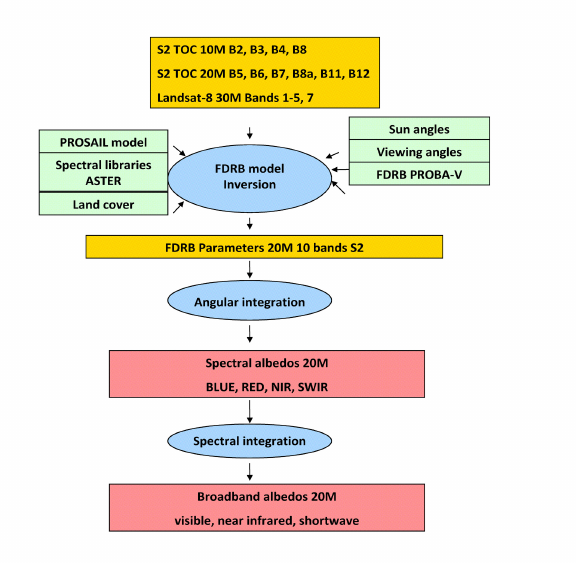
Figure 1: Flow chart of the algorithm for BRDF model inversion and albedo determination.